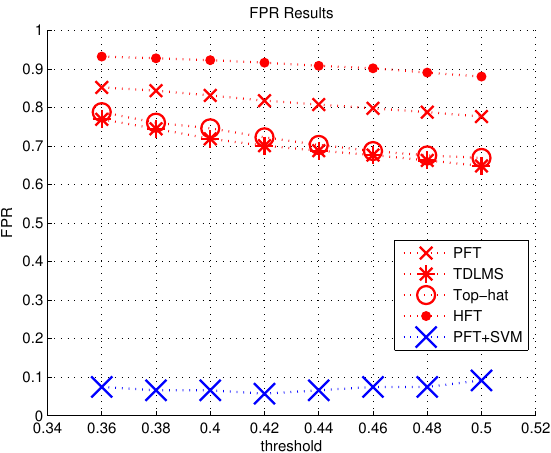
Figure 9. False positive rate (FPR) of all methods.